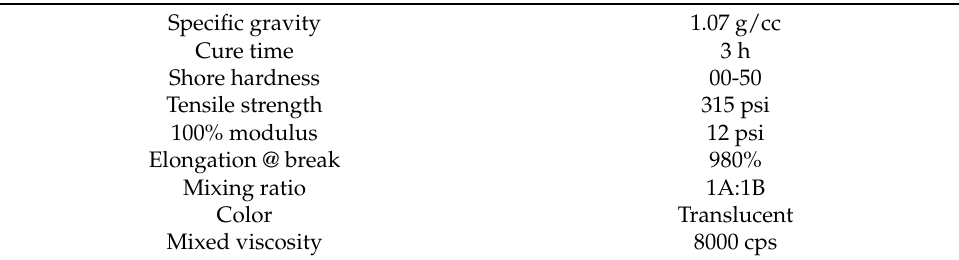
Figure 4. ( a – f ): Manufacturing procedure of the proposed sensor. Table 1. Material properties of Ecoflex 00-50.